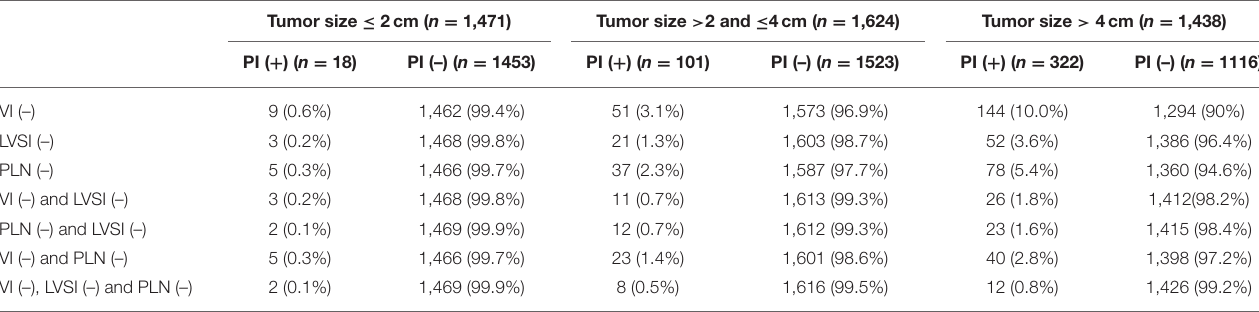
TABLE 2 | The number of the total patients and those with parametrial invasion based on the tumor size, vaginal involvement, status of the pelvic lymph nodes, and the lymphovascular space invasion. Tumor size ≤ 2cm ( n = 1,471) Tumor size > 2 and ≤ 4cm ( n = 1,624) Tumor size > 4cm ( n =